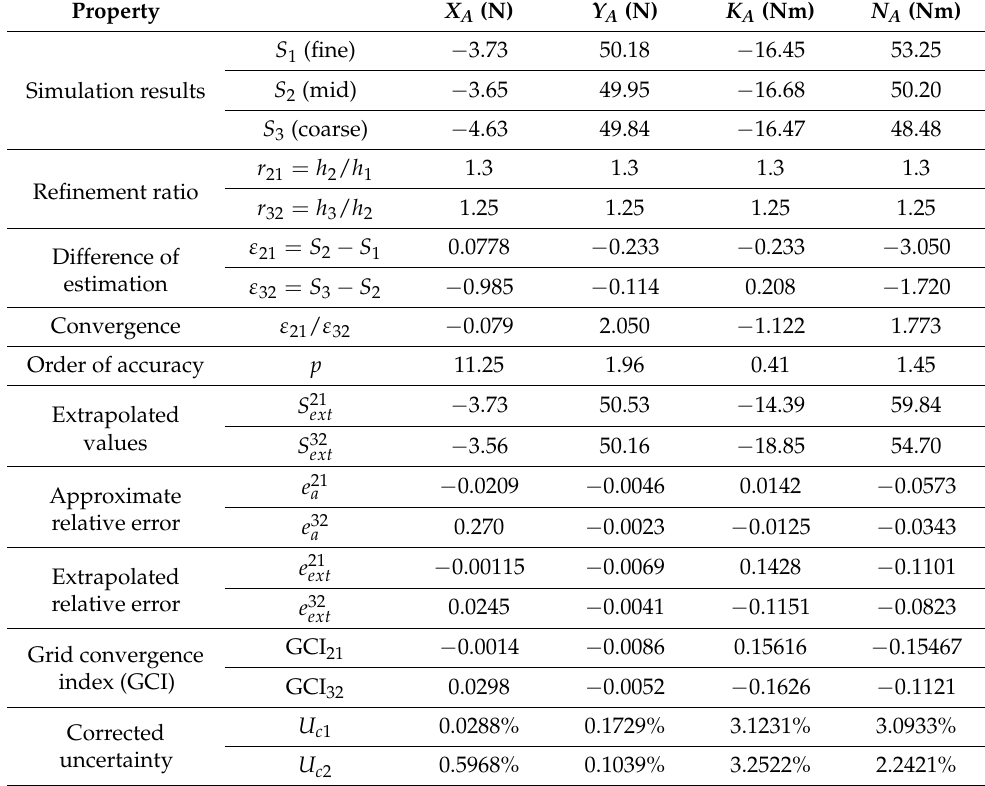
Table 3. Uncertainty analysis for the aerodynamic forces and